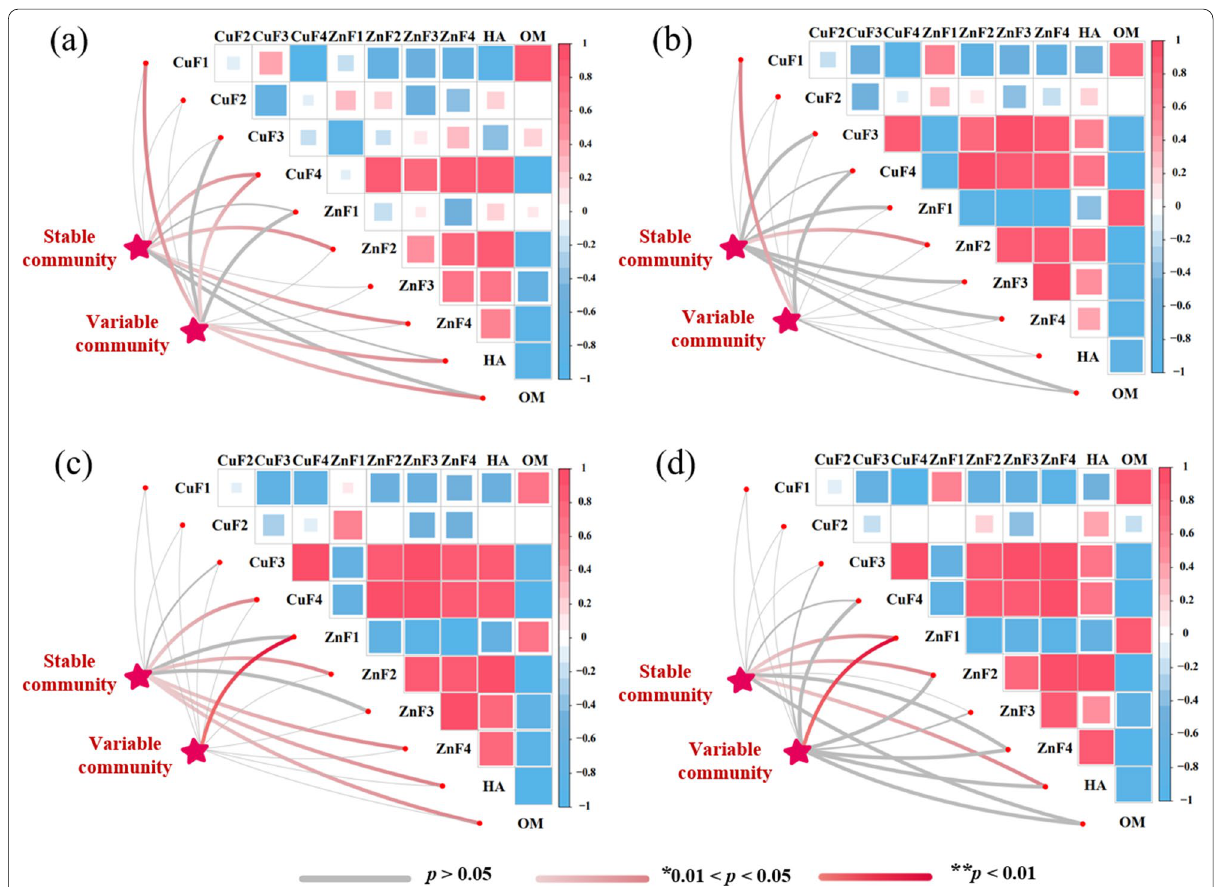
Fig. 5 Response relationships between stable community, variable community and environmental indicators during composting. a CK composting; b BC composting; c MB composting; d CB composting. Mantel test was employed to reveal links. Deep red lines: 0.001 < P < 0.01. Light red lines: 0.01 < P < 0.05. Gray lines: P > 0.05. CuF1: the acid-soluble fraction of Cu; CuF2: the reducible fraction of Cu; CuF3: the oxidizable fraction of Cu; CuF4: the residual fraction of Cu; ZnF1: the acid-soluble fraction of Zn; ZnF2: the reducible fraction of Zn; ZnF3: the oxidizable fraction of Zn; ZnF4: the residual fraction of Zn; HA: humic acid; OM: organic